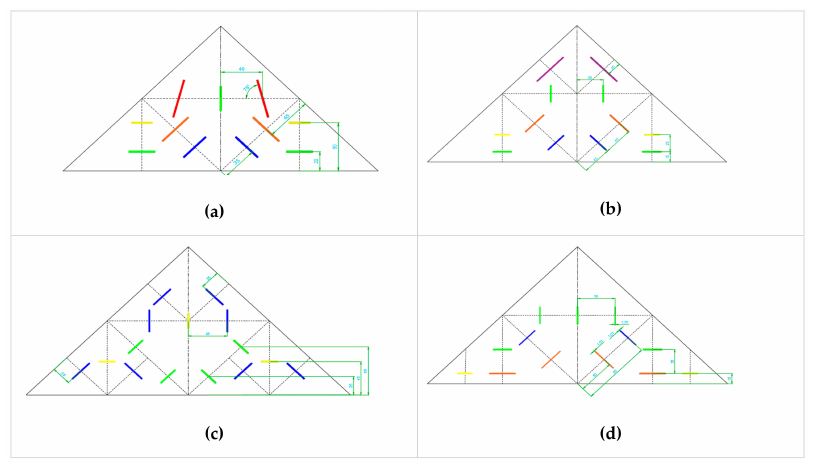
Figure7. SailprototypesconfigurationswithSMAelements: ( a )configurations1and2; ( b )configuration 3; ( c ) configuration 4; and ( d ) configurations 5 and 6. Length of SMA elements: 5 cm, 4 cm, 3.5 cm, 3 cm, 2.5 cm, 2 cm.